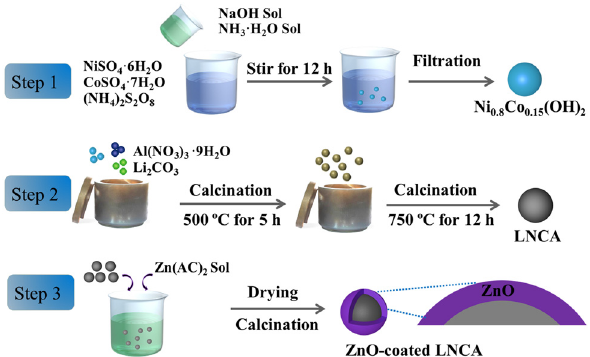
Figure 1: Schematic view of the synthesis process of ZnO - coated LiNi 0.8 Co 0.15 Al 0.05 O 2